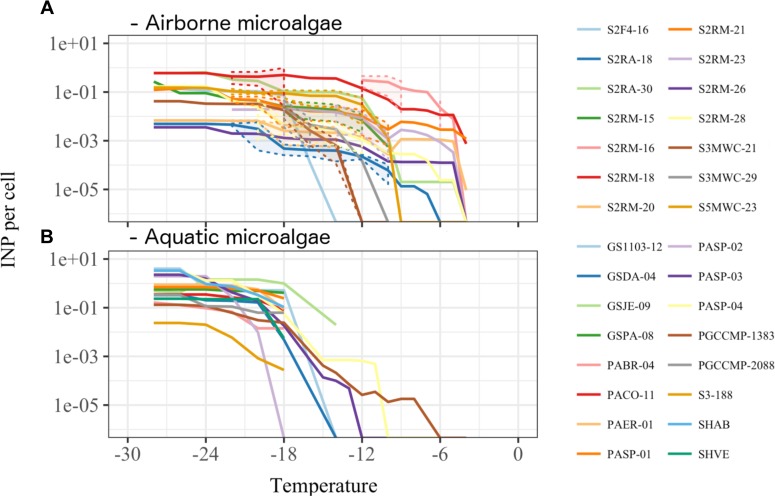
Ice nucleation activity estimated as number of ice nuclei per organism (A) for 14 airborne (Supplementary Table S2) and (B) for 16 aquatic microalgae (Supplementary Table S1). Dashed lines and shading in (A) indicate the standard deviation for the replicate measurements.